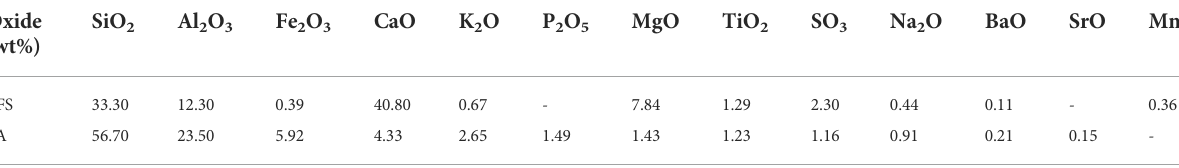
TABLE 1 Chemical composition of the binders in mass percent from X-ray fl uorescence spectroscopy.